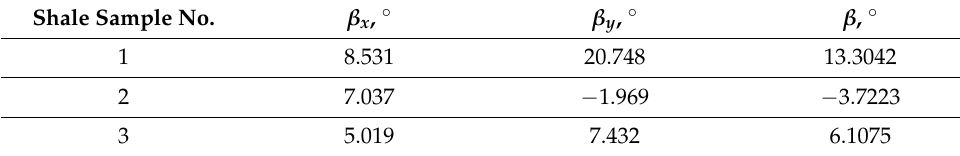
Table 6. Overall trend dip angle about shale fracture surface morphology. Shale Sample No. β x , ◦